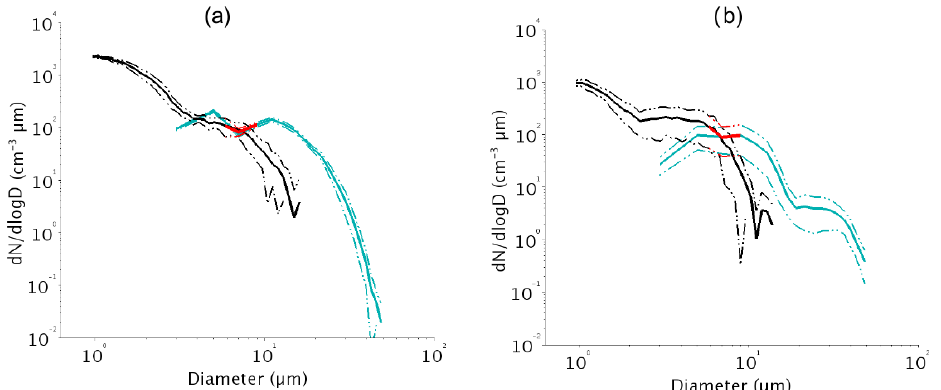
Figure 1. The 1h average composite number size distributions at ambient humidity derived from WELAS (black) and FM-100 (cyan) at the beginning of the fog event for cases (a) f6 and (b) f20. The solid line represents mean value and the dotted lines indicate ± 1 standard deviation. The red segments correspond to the result of merging both distributions between 6 and